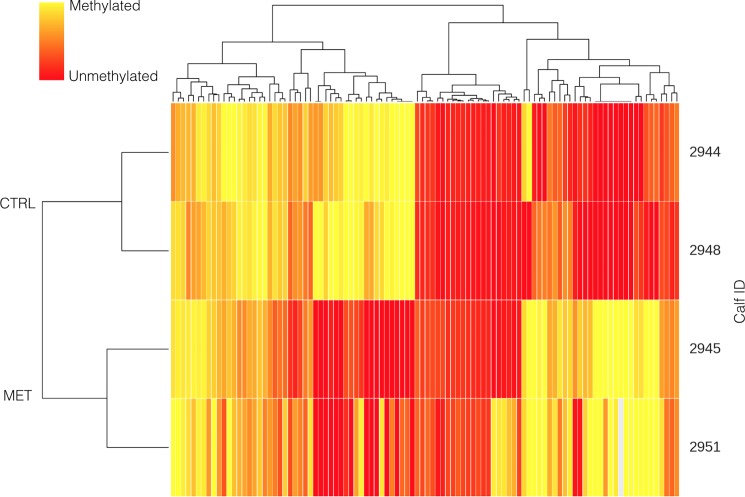
Cluster analysis of methylation status of CpG sites differentially methylated (p < 0.01) in the offspring born to non-lactating dams that received a supplementation of methyl donors or a placebo during early pregnancy (while lactating).Control dams received a placebo, whereas MET dams received weekly administrations of 100 mg of folic acid and 10 mg of vitamin B12.